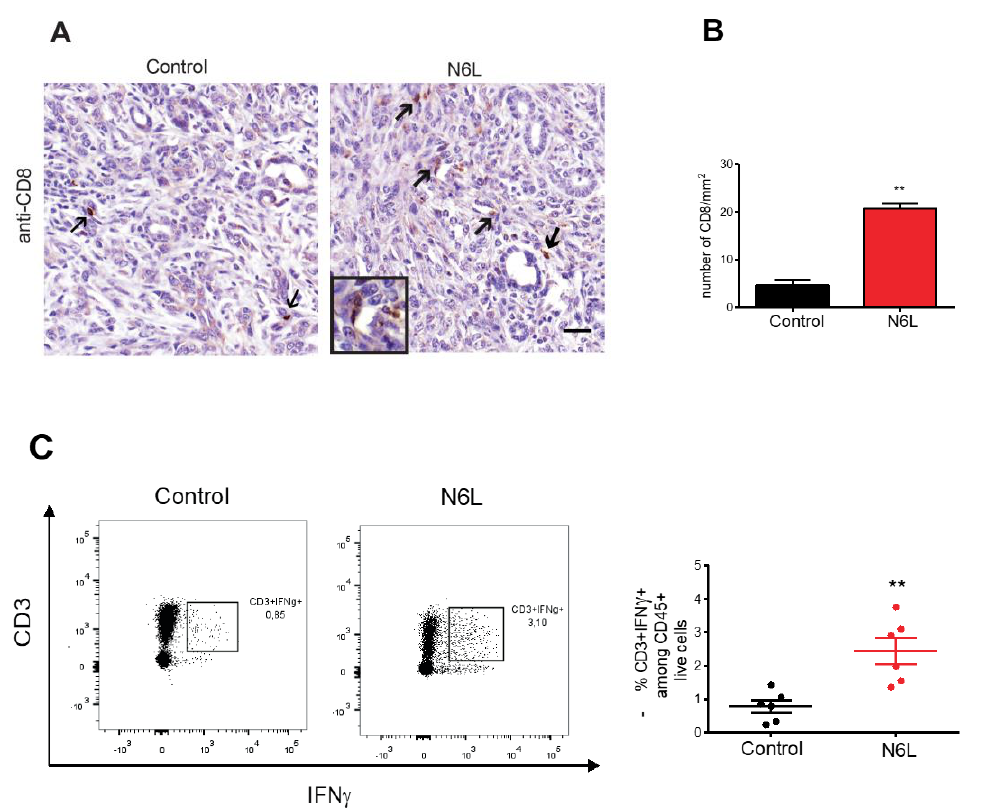
Figure 3. N6L increases lymphocyte infiltration and activation in mPDAC tumours. ( A ) Tumour sections of control and N6L-treated mice were immunostained by an anti-CD8 antibody to detect CD8 + cells (arrows); scale bar: 50 µ m. ( B ) CD8 + cells in tumoral regions (at least 4) of tumour slices were counted by using QuPath software, and the results were plotted as a mean for each tumour (n = 6) as the number of cells/mm 2 . Two-tailed Mann-Whitney U-test (**, p < 0.01; n = 5 tumours) was applied. ( C ) Effector T cell activation was analysed by flow cytometry, and the % of CD3 + IFN γ + cells in control and N6L-treated mice is plotted (two-tailed Mann-Whitney U-test **, p < 0.01; n = 6 mice).